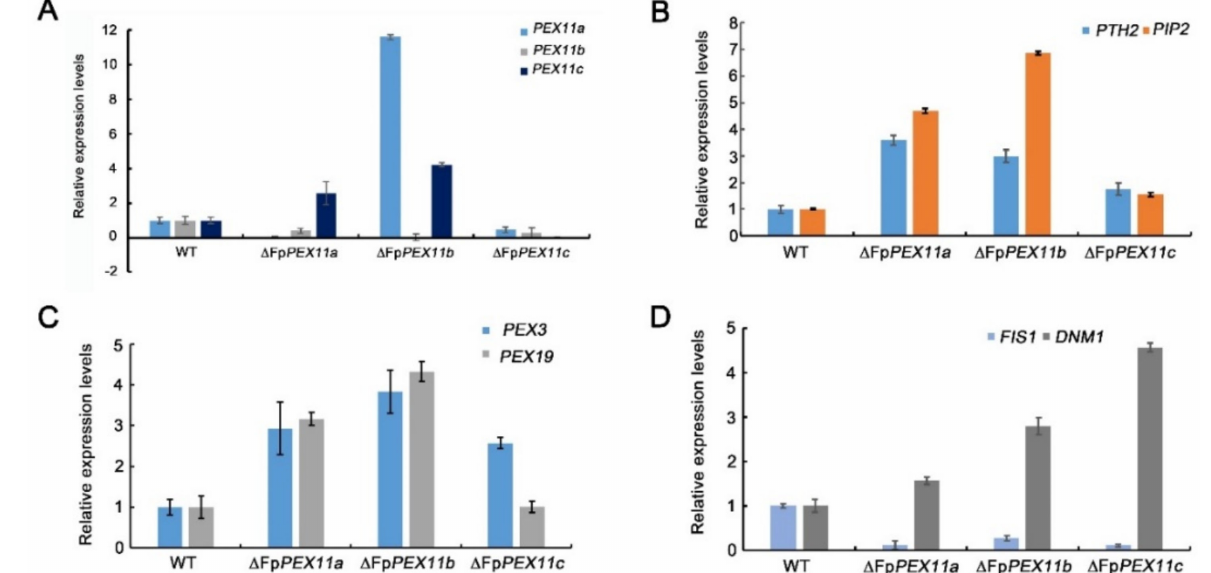
Figure 8. FpPEX11 − related gene expression assay results. ( A ) Relative expression levels of mutual PEX11 in the ∆ FpPEX11 mutants. ( B ) Relative expression levels of PTH2 and PIP2 in ∆ FpPEX11 mutants. ( C ) Relative expression levels of PEX3 and PEX19 in ∆ FpPEX11 mutants. ( D ) Relative expression levels of FIS1 and DNM1 in ∆ FpPEX11